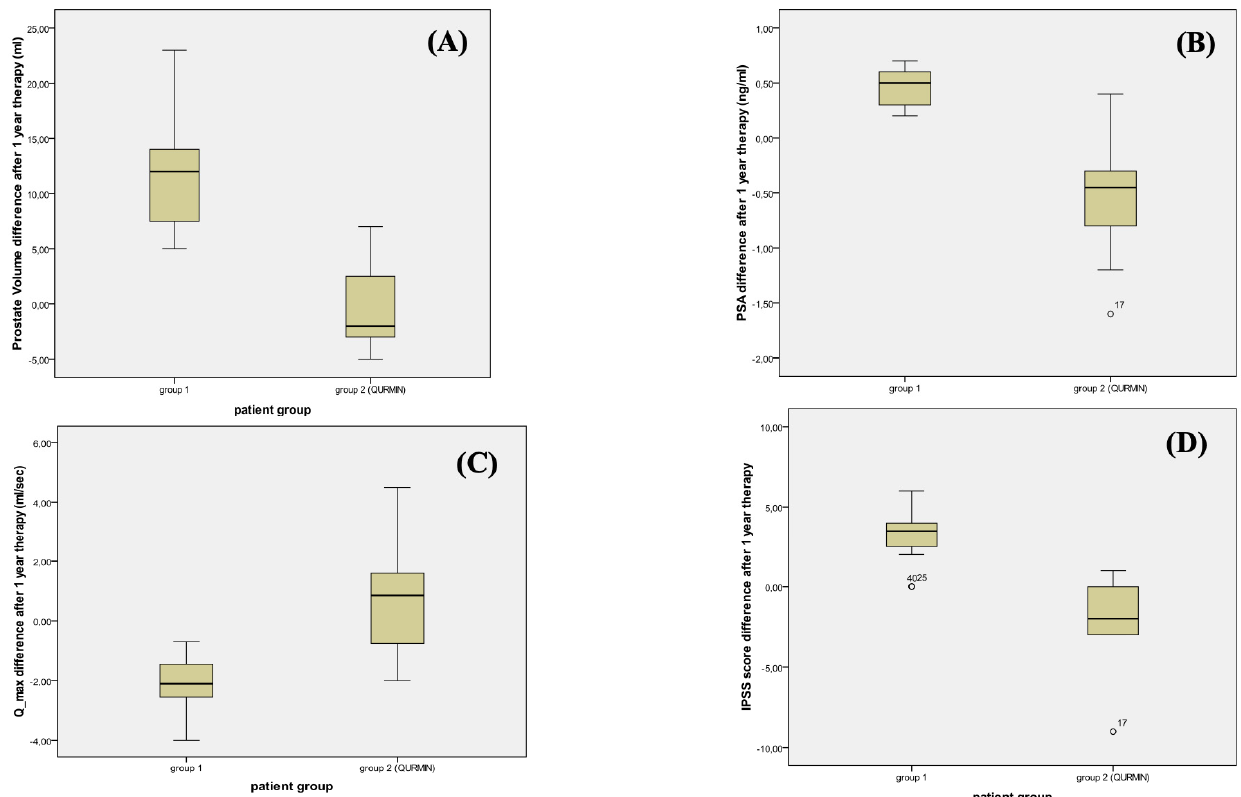
Figure 1. Box plot graphs of change after 1 year of therapy in both groups for ( A ) prostate volume (PV); ( B ) prostate-specific antigen (PSA); ( C ) maximum flow rate (Q-max); ( D ) international prostate symptom score (IPSS).